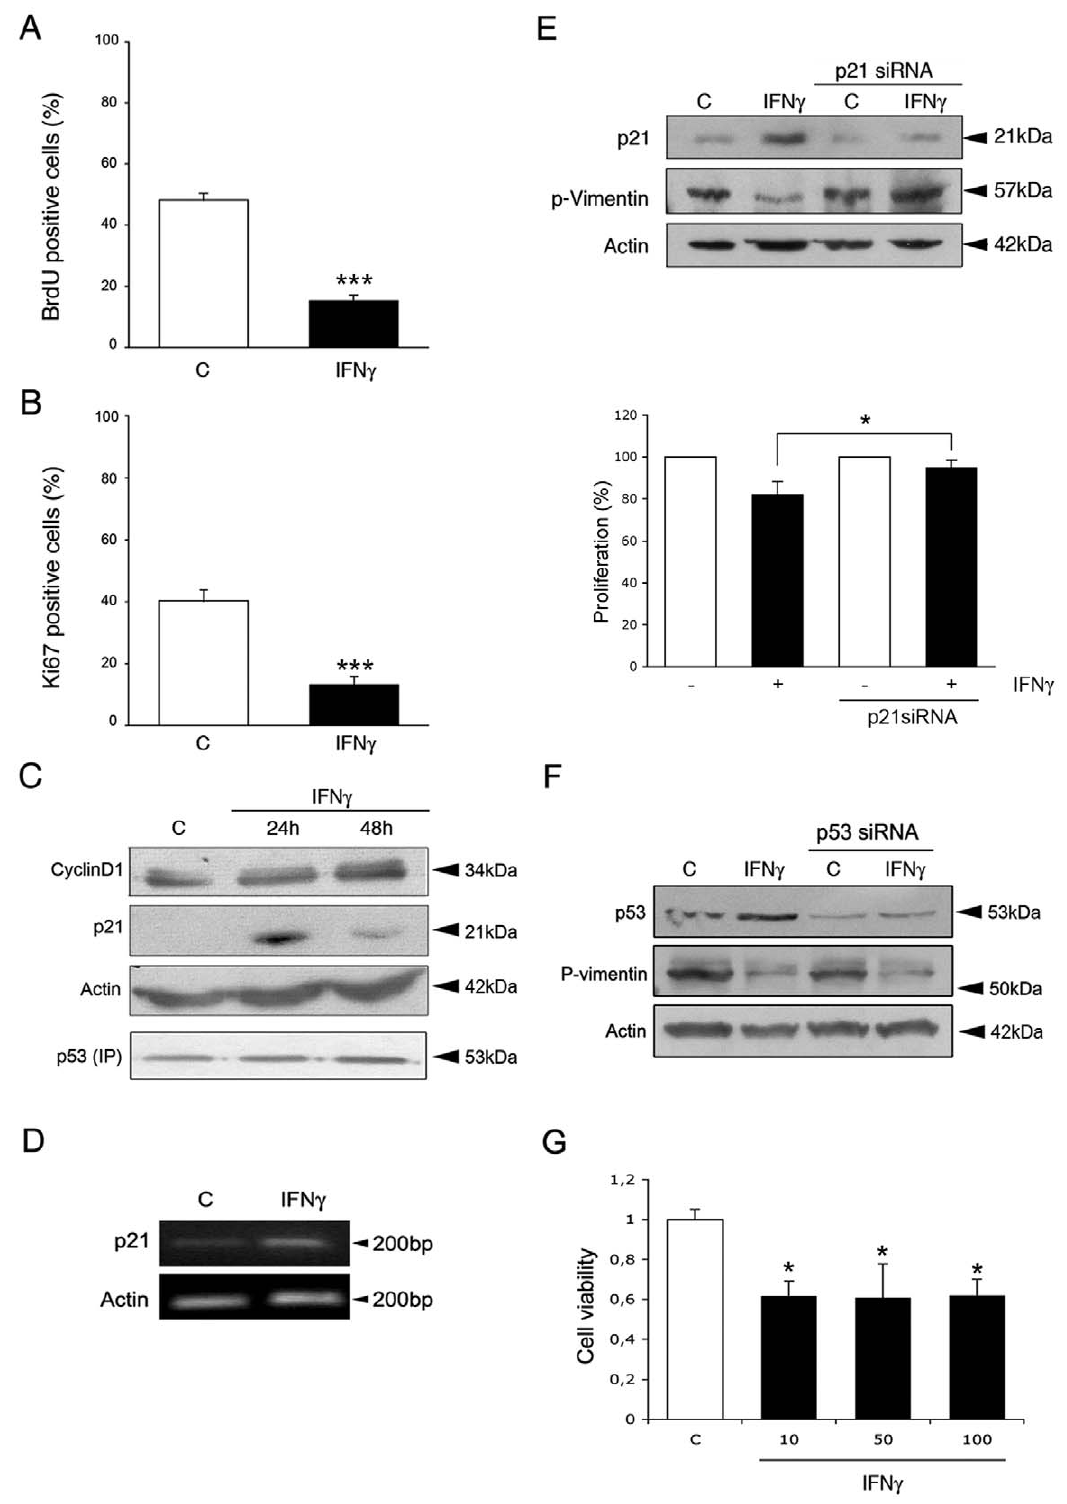
Figure 3. IFN c decreases cell proliferation of NPCs via p21. NPCs were treated with 100 ng/ml IFN c for 2 days. *p , 0.05 and ***p , 0.001 comparing IFN c treated vs. controls. ( A ) 10 m M BrdU was added to the cultures to label DNA and immunostaining done using anti-BrdU antibodies. Values are means 6 SD, n=4. ( B ) Immunostaining using antibody against Ki67. Values are means 6 SD, n=4. ( C ) Immunoblots. Cells were treated for 24 h. Note upregulation of p21 with no change in cyclinD1. Immunoprecipitation (IP) of p53 was performed prior to blotting. ( D ) RT-PCR for p21 was done as described. Typical experiment is shown and was repeated 3 times. ( E ) NPCs were treated with siRNA against p21 for 2 days followed by IFN c for 24 h Upper panel, Immunoblots showing p-vimentin as a measure of cell proliferation. IFN c decreased p-vimentin in control but not in p21-siRNA